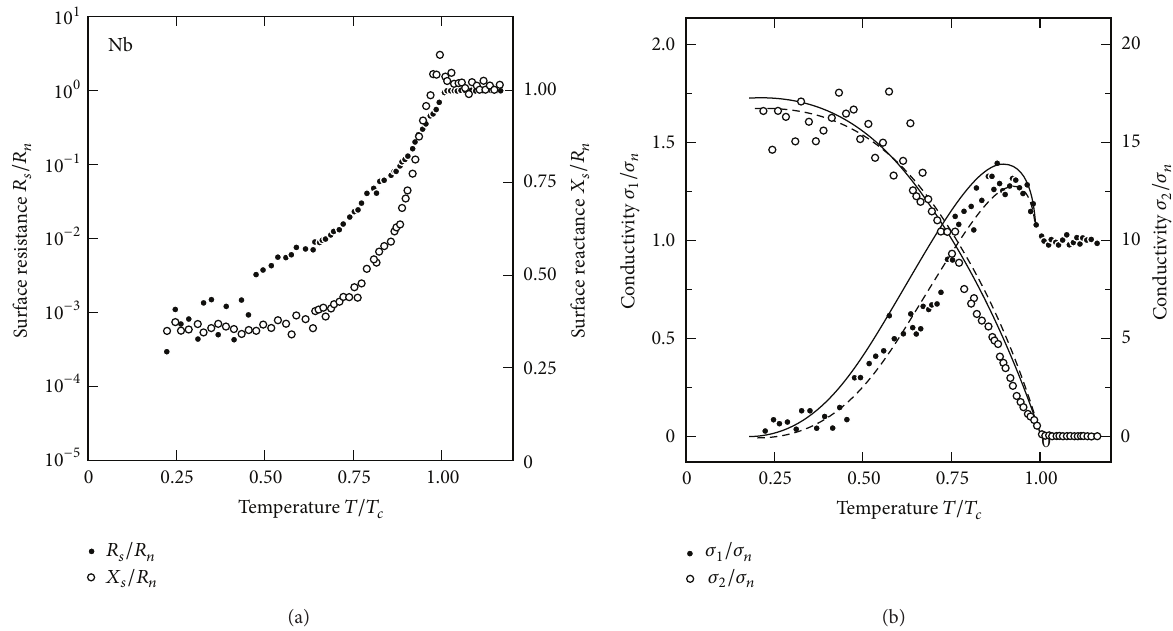
Figure 8: (a) Real component 𝑅 𝑠 (𝑇) (referring to the logarithmic scale on the left axis) and imaginary component 𝑋 𝑠 (𝑇) (right axis) of the surface impedance of niobium, normalized to the normal state surface resistance 𝑅 𝑛 measured at 60GHz as a function of temperature. (b) Temperature dependence of the components of the conductivity 𝜎 1 (𝑇) and 𝜎 2 (𝑇) in niobium calculated from the results of the surface impedance shown in (a). Note the enhancement of 𝜎 1 (𝑇) just below 𝑇 𝑐 = 9.2 K. The full lines are calculated using the Mattis–Bardeen formalism [(1) and (2)] in the local limit, and the dashed lines follow from the Eliashberg theory of a strong coupling superconductor (after [37, 46]).